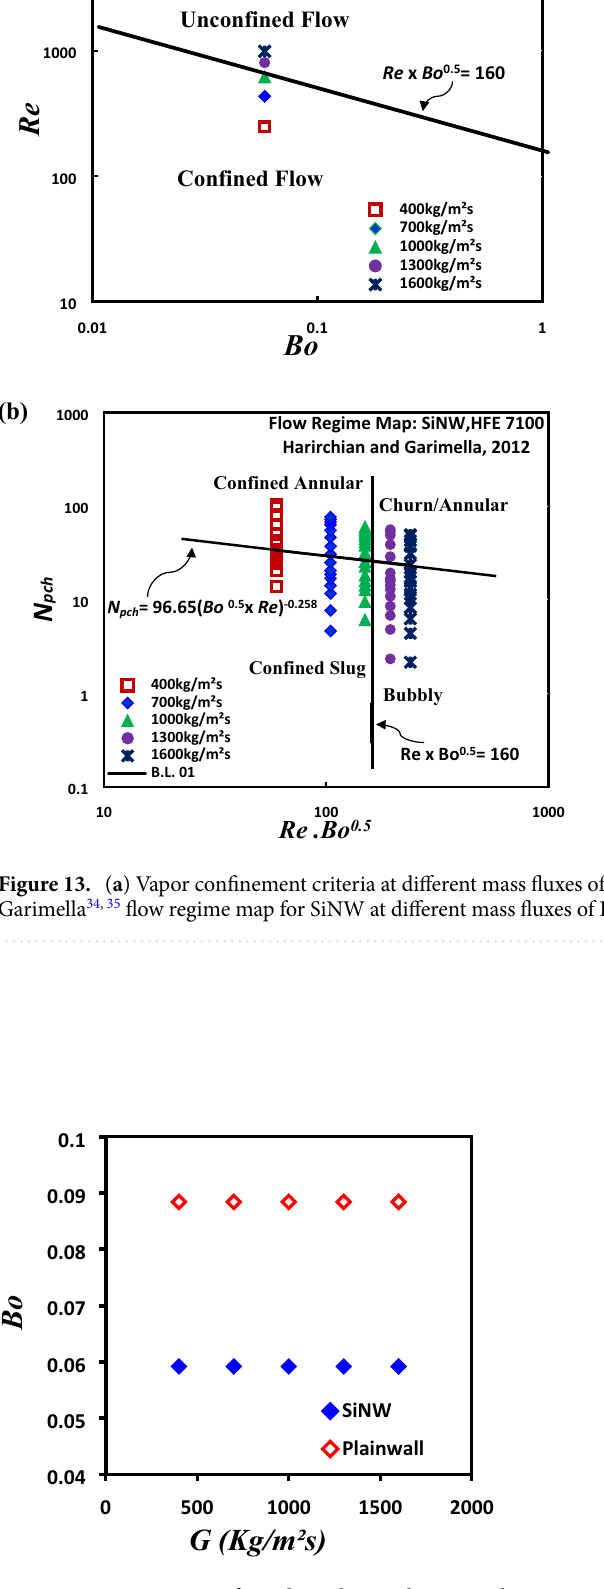
Figure 14. Comparison of Bond number, Bo between silicon nanowire and plainwall